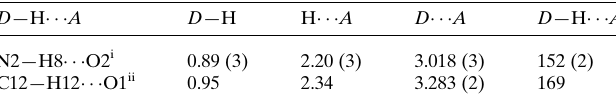
Table 1 Hydrogen-bond geometry (A˚ , (cid:2) ).